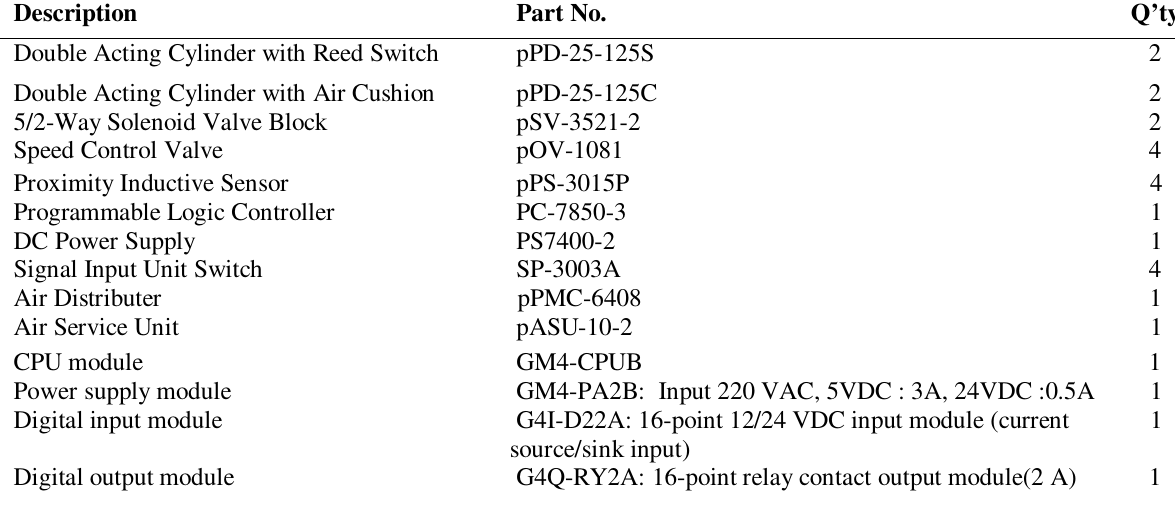
Main Components of the PPS Control System Experimental Setup Description Part